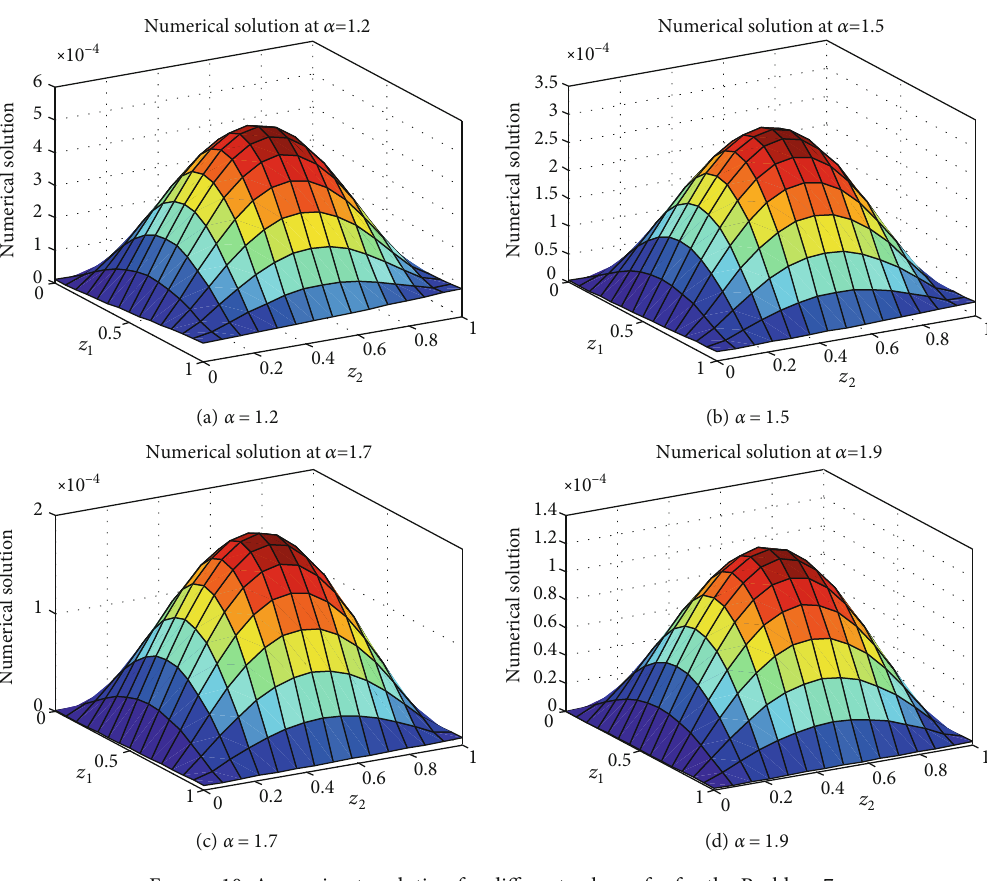
Figure 10: Approximate solution for di ff erent values of α for the Problem 7.